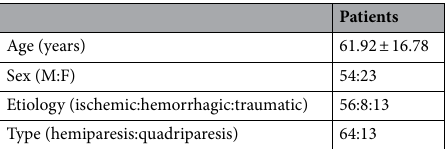
Table 1. Clinical and demographic characteristics of included patients with brain lesion. M:F male:female.